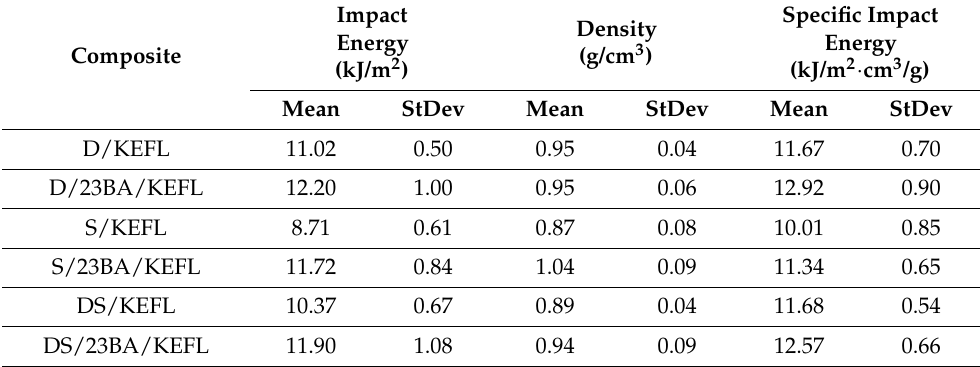
Table 9. Charpy impact analysis of